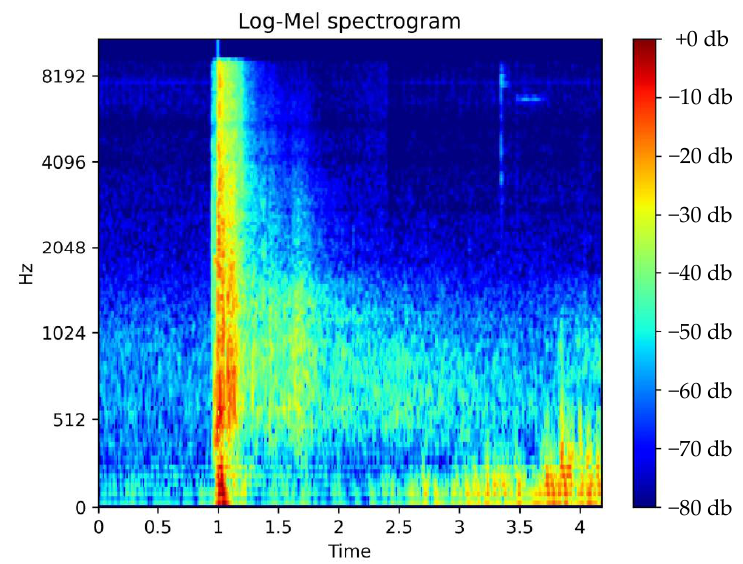
Figure 2. Log-Mel Figure 2. Log-Mel spectrogram.